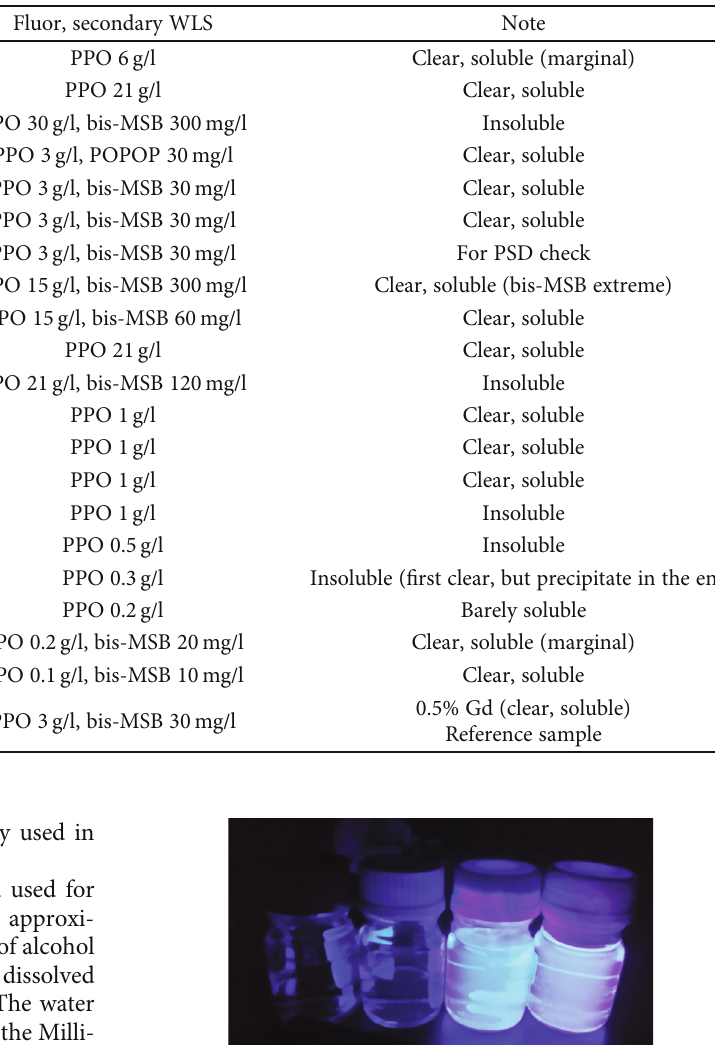
Table 1: Samples used for synthesizing alcohol-based liquid scintillator. In the standard sample (R), used as a reference, 3 g/l PPO was dissolved and 30 mg/l bis-MSB was mixed as the second WLS in the LAB and UG-F. The S samples indicate alcohol-based LS and NE samples based on 2-ethoxyethanol solvent.